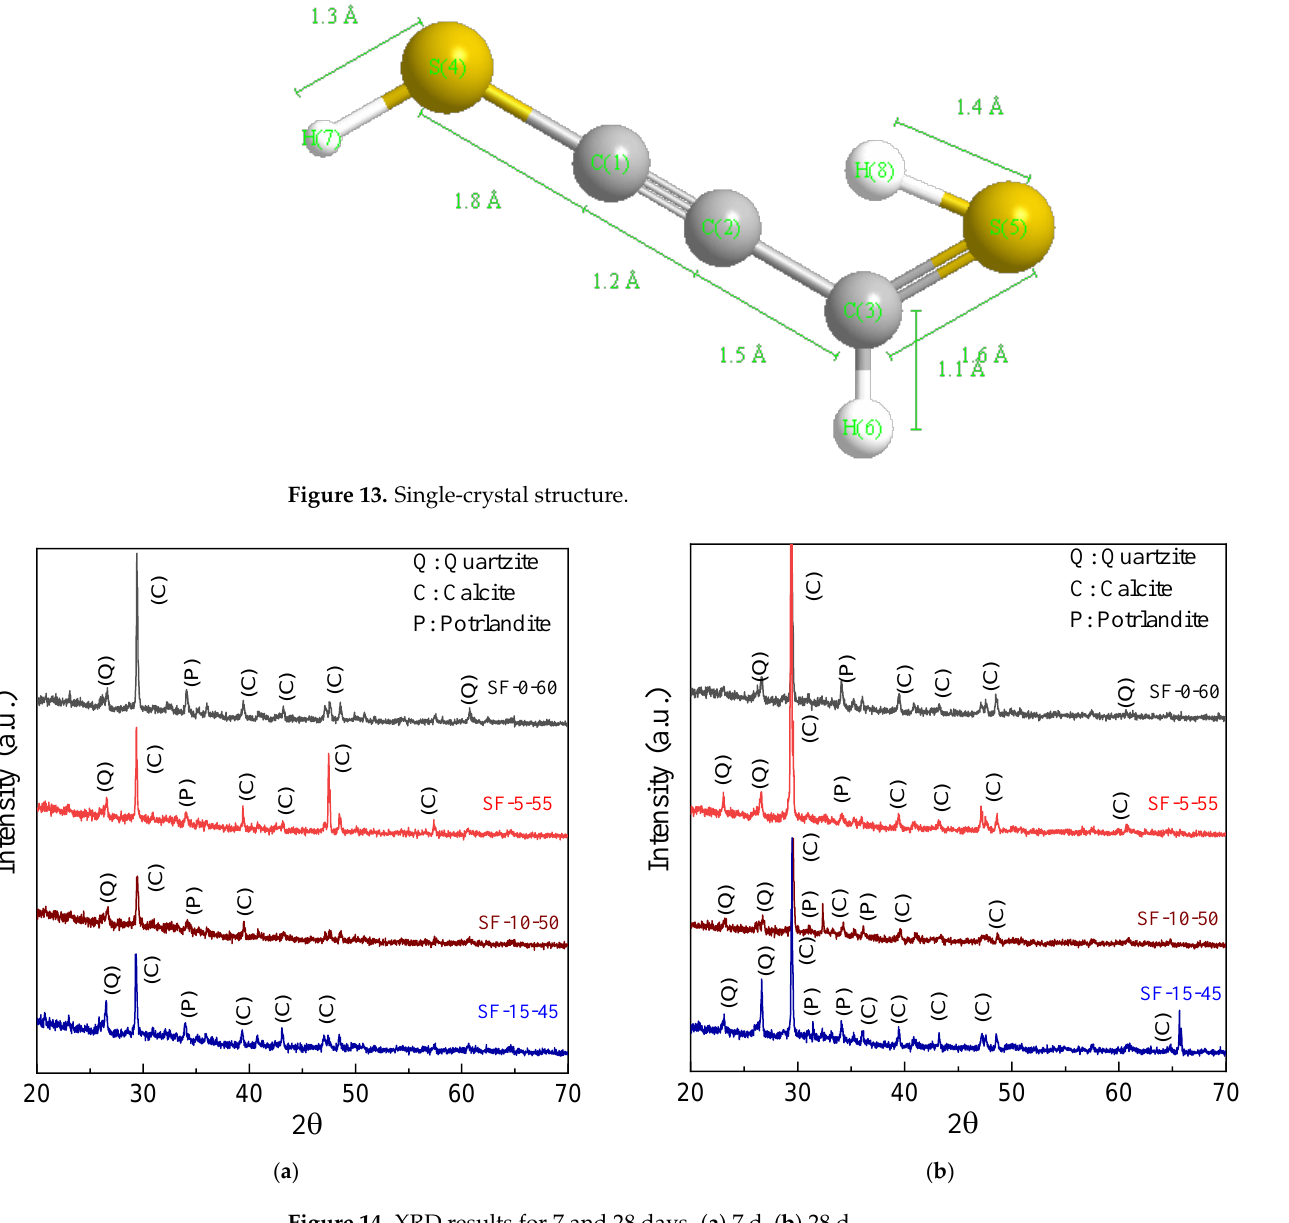
Figure 14. XRD results for 7 and 28 days. ( a ) 7 d, ( b ) 28 d. Table 5. XRF results of slag/fly-ash-based ECC at 28